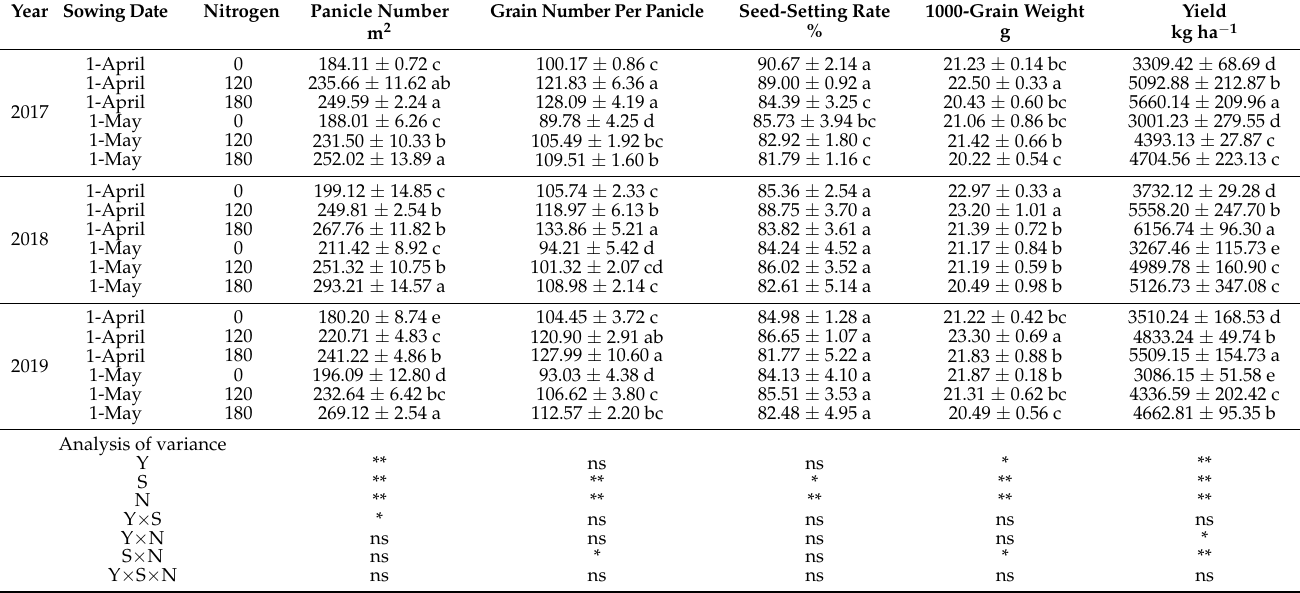
Table 3. Effect of sowing date and nitrogen application on yield and yield